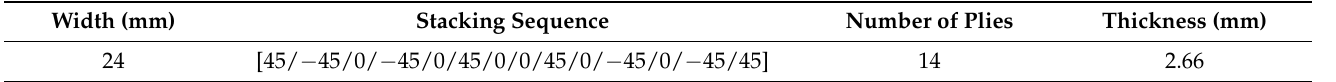
Table 3. Stacking sequences and thicknesses of the open hole